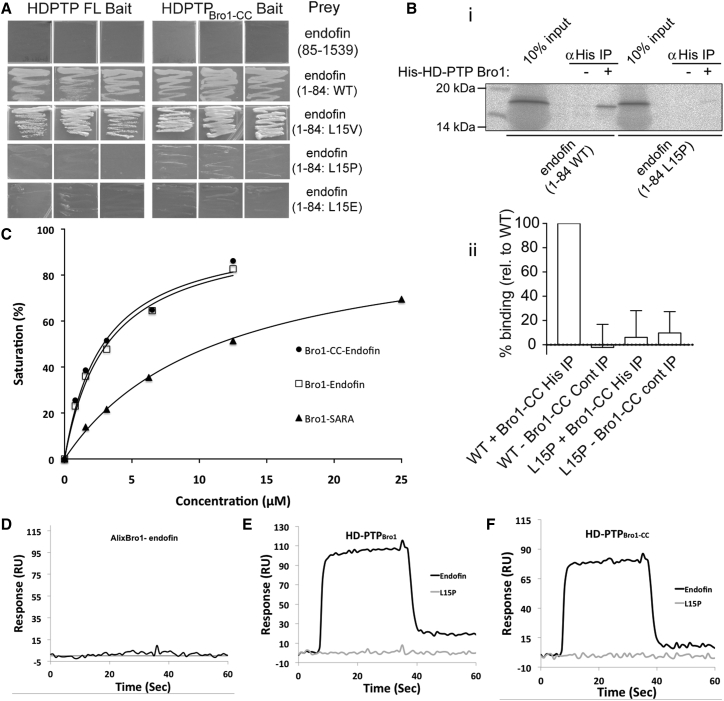
Mapping the HD-PTP Binding Interactions with SARA and Endofin(A) Y2H assays between endofin(1–84) constructs or endofin(85–1,539) and HD-PTPFL or HD-PTPBro1-CC shows that binding is restricted to the endofin N terminus and that endofin L15 is important for binding. Data are from a representative experiment performed in triplicate.(B) In vitro translated endofin1–84-strep, but not endofin(1–84/L15P)-strep, is co-immunoprecipitated with bacterially expressed His6-HD-PTPBro1-CC after an incubation with anti-His6 antibody; (i) is an example experiment, (ii) is quantitation from three independent experiments (mean ± SD).(C) Biosensor binding isotherms for the HD-PTPCC and HD-PTPBro1-CC binding to endofin and SARA 22-mer peptides, used to determine the binding affinities (HD-PTPBro1 and HD-PTPBro1-CC binding to the endofin peptide have KD 3.1 ± 0.1 μM and 2.7 ± 0.1 μM, respectively, and HD-PTPBro1 has KD 11.3 ± 0.3 μM to SARA).(D) Biosensor sensogram showing the lack of binding of the endofin peptide to AlixBro1.(E and F) Sensograms showing that mutation of endofin L15 to proline abolishes binding to HD-PTPBro1 (E) and HD-PTPBro1-CC (F) compared with the control experiment using the wild-type endofin peptide.